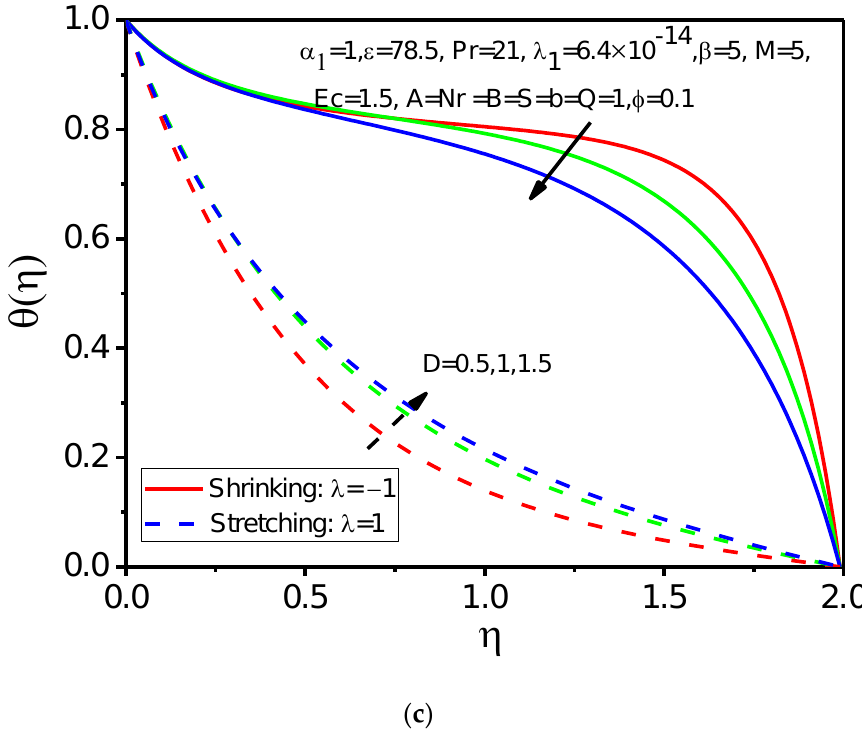
Figure 7. Variation of D on ( a ) Velocity profile, ( b ) Pressure profile, ( c ) Temperature profile.